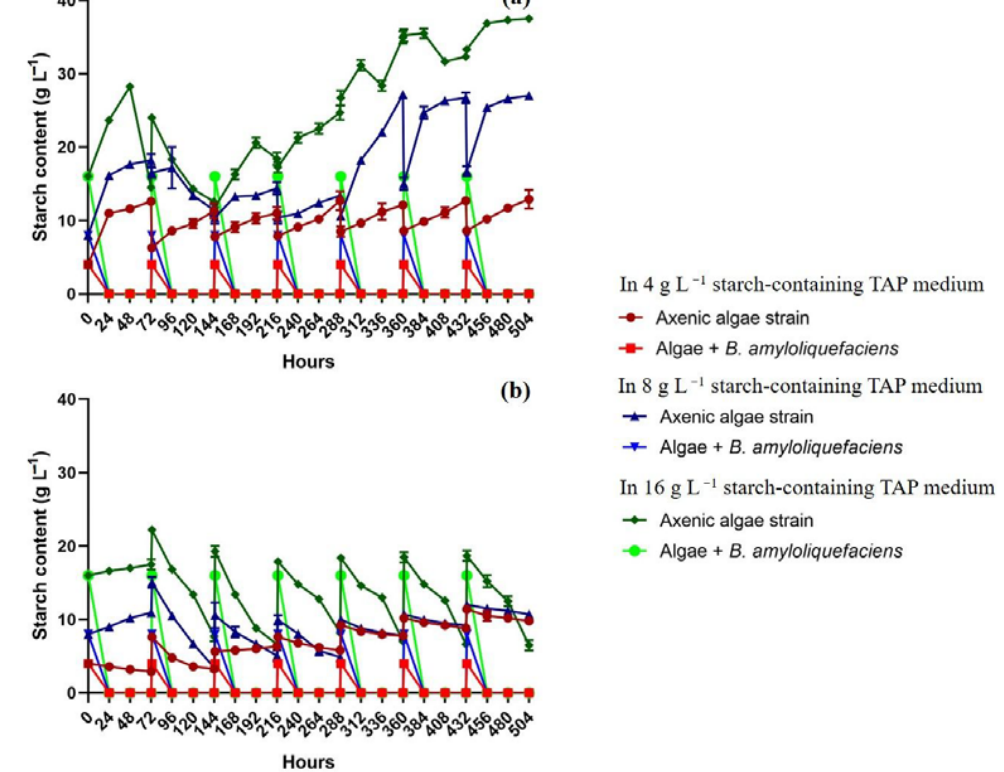
Figure 2. Starch content in the axenic and co-cultures of C. reinhardtii cc124 ( a ) and Chlorella sp. MACC-360 ( b ) in fed-batch experiments (the initial bacterial OD 600 of 0.07). Starch content was measured every 24 h. Error bars are standard deviations based on three replicates.